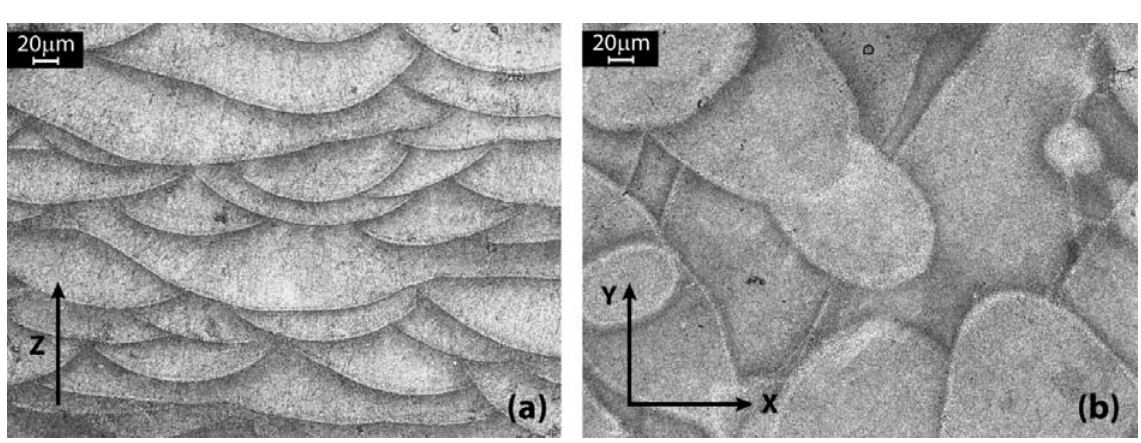
Figure 6. Optical microscope images of an aluminum alloy DMLS sample after etching with Weck’s reagent: ( a ) a section along the build direction ( z axis); ( b ) a section parallel to the powder deposition plane ( xy -plane).